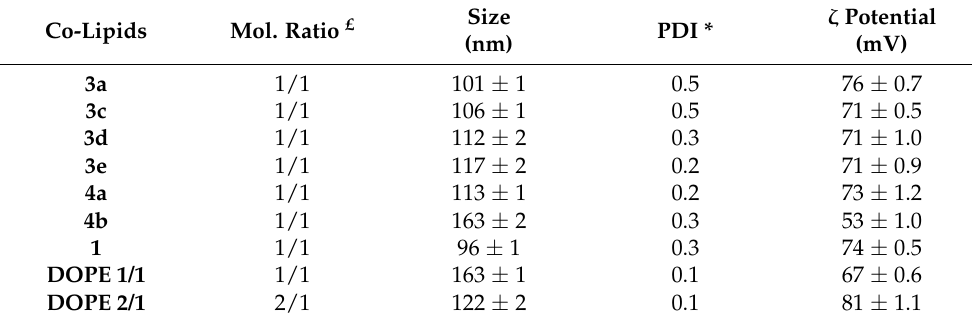
Table 2. Physicochemical characterization of 2 -based liposomes. Co-Lipids Mol. Ratio £